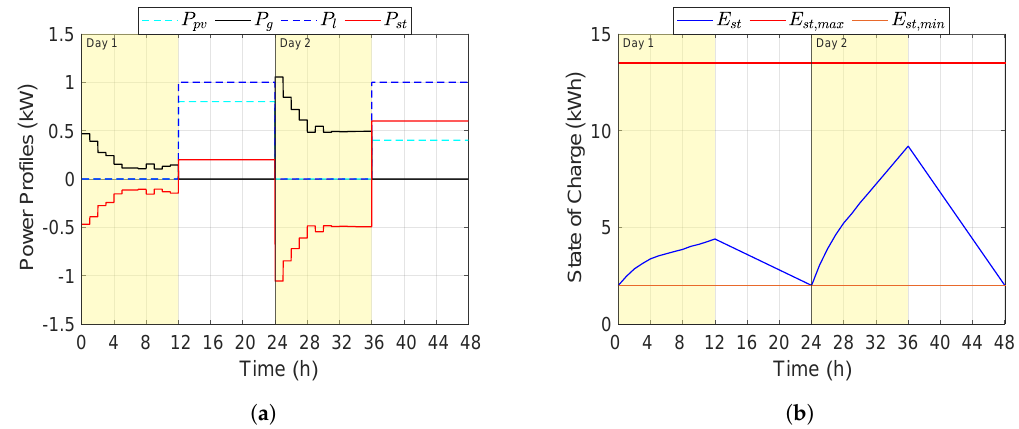
Figure 5. Simulation results given by the predictive controller considering a simple scenario. On the left power profiles are given, on the right the state of charge is reported: ( a ) Power Profiles; ( b ) State of